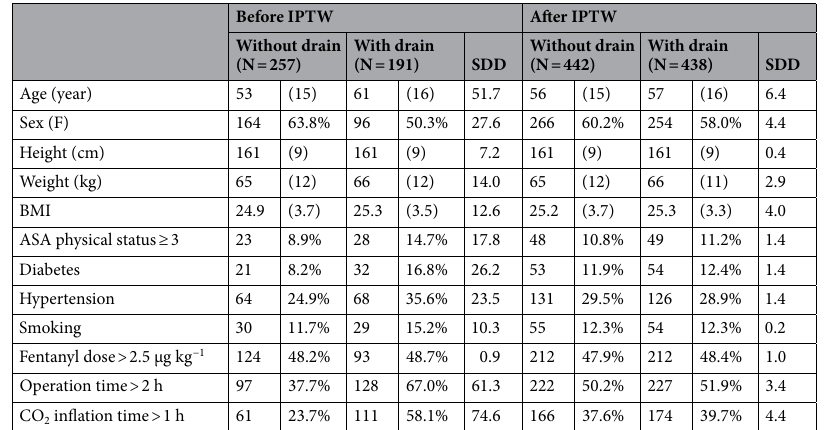
Table 1. Comparisons of baseline characteristics between the groups with drain and the other without drain before and after IPTW adjustment. Categorical data are showed as count with percentage and parametric data are presented as mean with (standard deviation). IPTW inverse probability treatment weighting, SDD standardized difference expressed in percentage, an absolute value greater than 20 indicates imbalance, BMI body mass index.